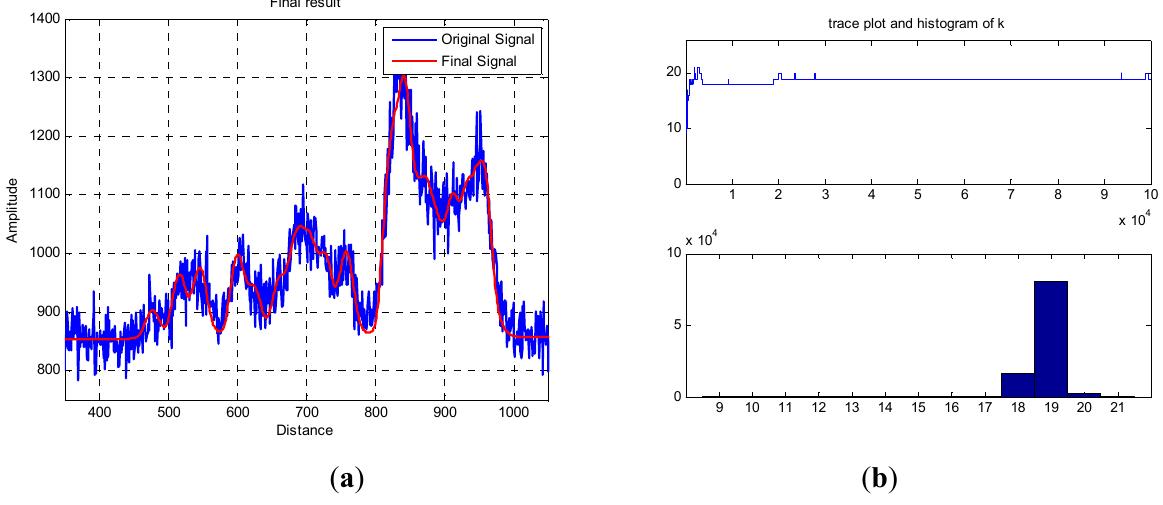
Figure 5. ( a ) Integrated response from all 100 pixels of the tree image. The blue curve shows the real, raw data, and the red curve the result of a synthetic, noise-free waveform generated from the parameter estimation by RJMCMC. ( b ) This shows the trace of k for 10 5 iterations, and the a-posteriori distribution on k , the number of layers used to approximate the